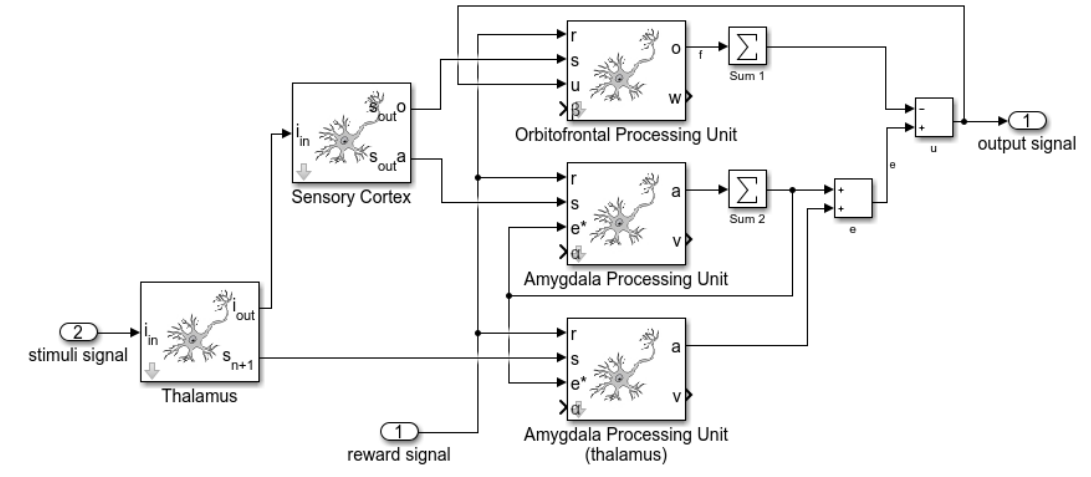
Figure 4. Brain–emotional learning model block diagram.